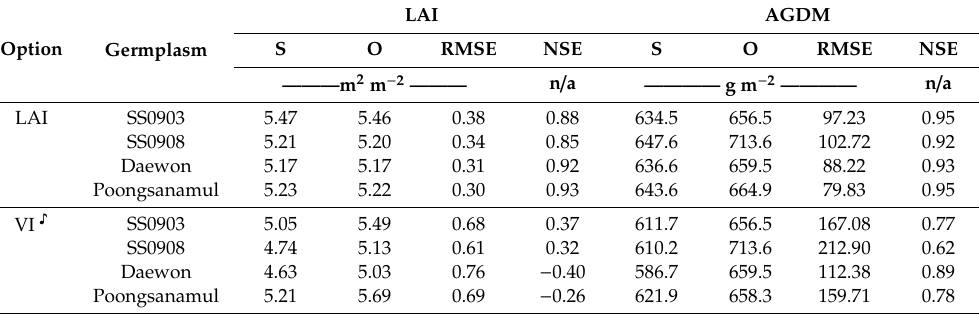
Table A2. Error statistics of root mean square (RMSE) and Nash–Sutcli ff e e ffi ciency (NSE) in comparison between simulation (S) and observation (O) of leaf area index (LAI) and above ground dry mass (AGDM) for soybean germplasms or cultivars, simulated with di ff erent input options (i.e., LAI or VI) for the RSCM regime using the data obtained at Chonnam National University, Gwangju, South Korea in